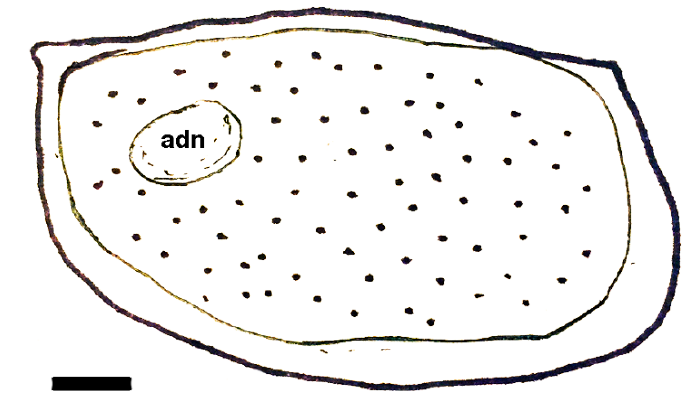
Figure 13. Euzepaera sp. Anterior to left. Scale bar 100 microns. Abbreviation: adn , anterodorsal node. Image Credit: Mark McMenamin.